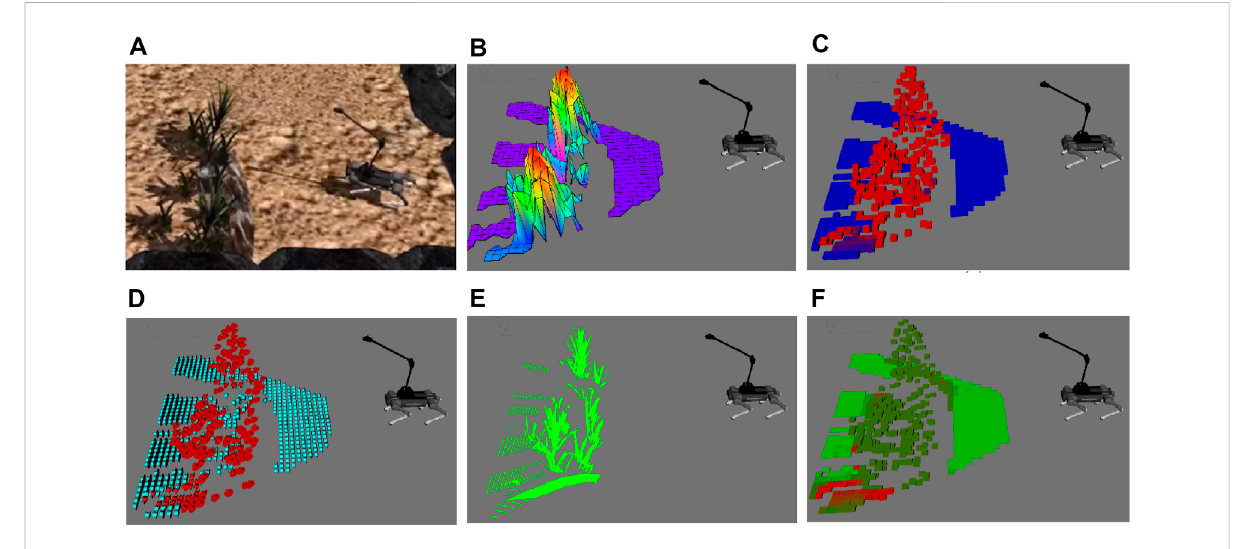
FIGURE 2 Visualization of traversability terrain properties. (A) Gazebo simulation of planted terrain, (B) elevation map, and (C) roughness map, where red indicates rough and blue indicates smooth areas; (D) slopemap where red indicates steep slope and light blue indicates traversable slope; (E) plant ’ s segmented point cloud; (F) local traversability map, light green indicates traversable and red